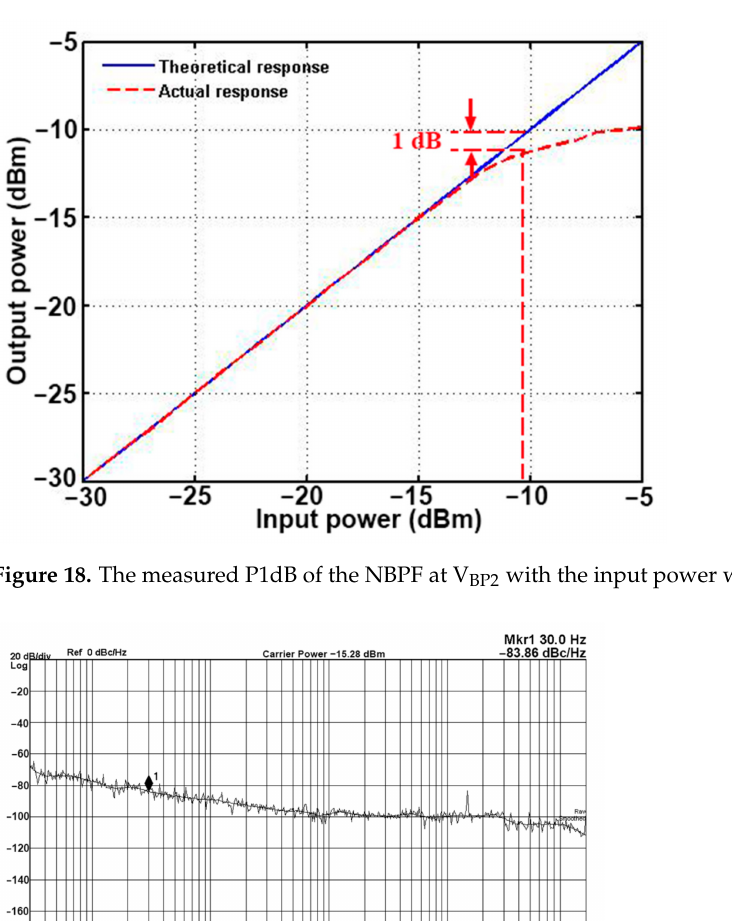
Figure 17. The NBPF at the V BP2 output spectrum for a two-tone intermodulation distortion test.